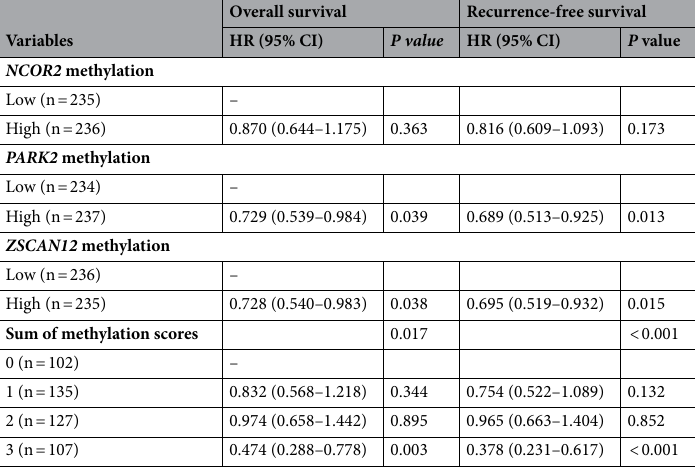
Table 1. Multivariate analysis of overall survival and recurrence-free survival. Adjusted for age, tumor subsite, T category, N category, M category, lymphatic emboli, venous invasion, and perineural invasion. HR hazard ratio, CI confidence interval.